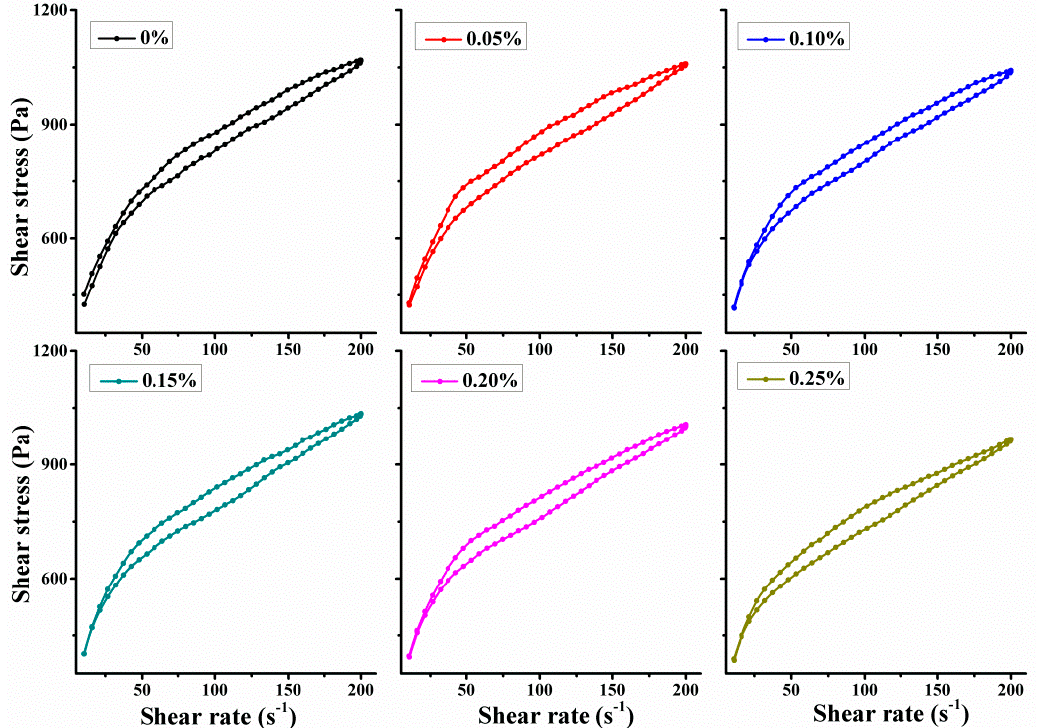
Figure 9. The hysteresis loop surrounded by up and down curves of shear stress.